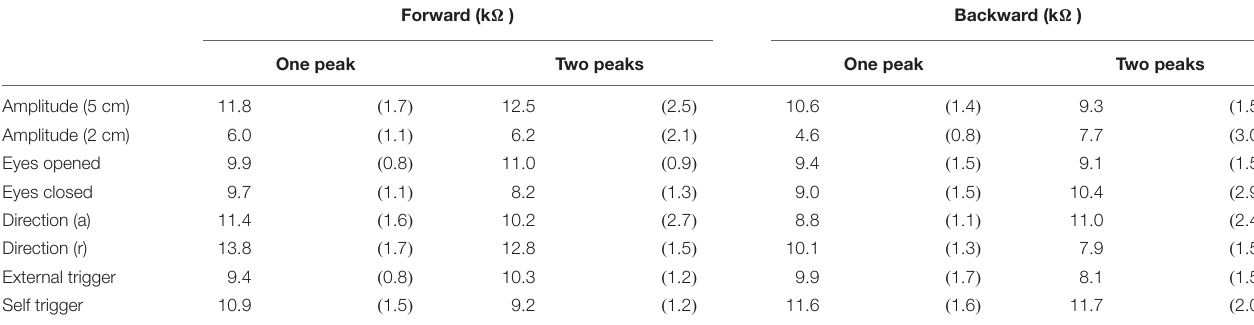
TABLE 10 | Amplitude of one-peak EDR and that of second peak in two-peak EDR.